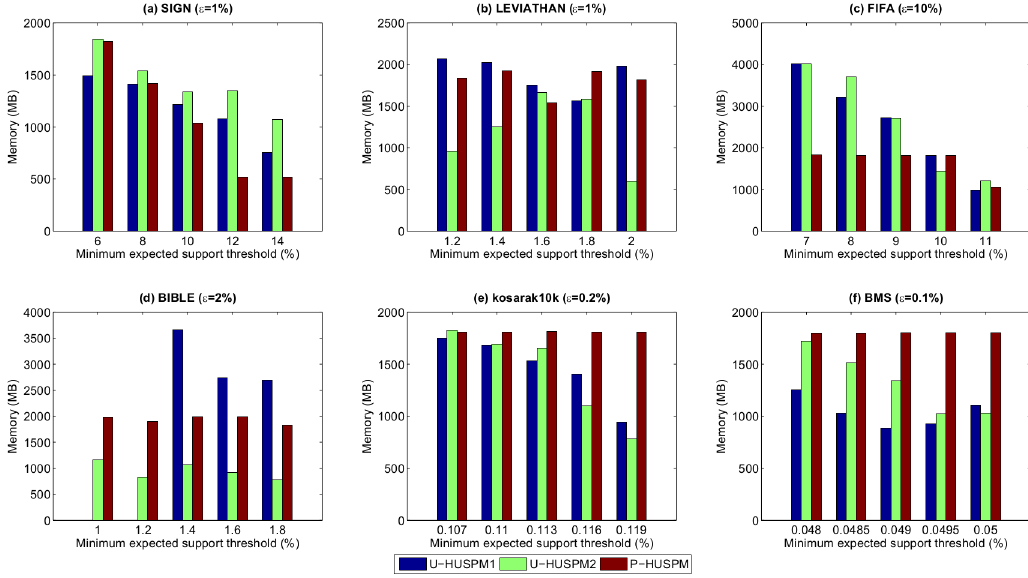
Fig 6. Memory usage for a fixed ε when μ is